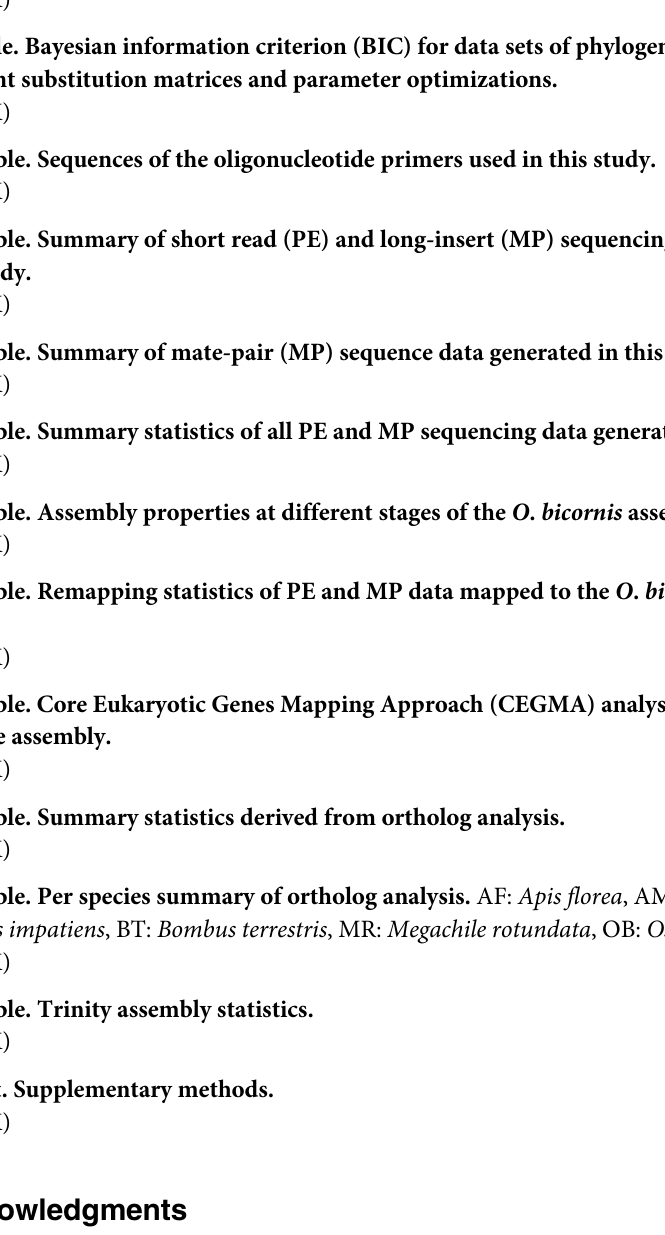
S8 Table. Genes identified as significantly differentially expressed in RNAseq data between thiacloprid treated and untreated O . bicornis female bees. S9 Table. Bayesian information criterion (BIC) for data sets of phylogenetic trees using different substitution matrices and parameter optimizations. S10 Table. Sequences of the oligonucleotide primers used in this study. S11 Table. Summary of short read (PE) and long-insert (MP) sequencing data generated in this study. S12 Table. Summary of mate-pair (MP) sequence data generated in this study. S13 Table. Summary statistics of all PE and MP sequencing data generated in this study. S14 Table. Assembly properties at different stages of the O . bicornis assembly pipeline. S15 Table. Remapping statistics of PE and MP data mapped to the O . bicornis –v3 assem- bly. S16 Table. Core Eukaryotic Genes Mapping Approach (CEGMA) analysis of the O . bicornis genome assembly. S17 Table. Summary statistics derived from ortholog analysis. S18 Table. Per species summary of ortholog analysis. AF: Apis florea , AM: Apis mellifera , BI: Bombus impatiens , BT: Bombus terrestris , MR: Megachile rotundata , OB: Osmia bicornis . S19 Table. Trinity assembly